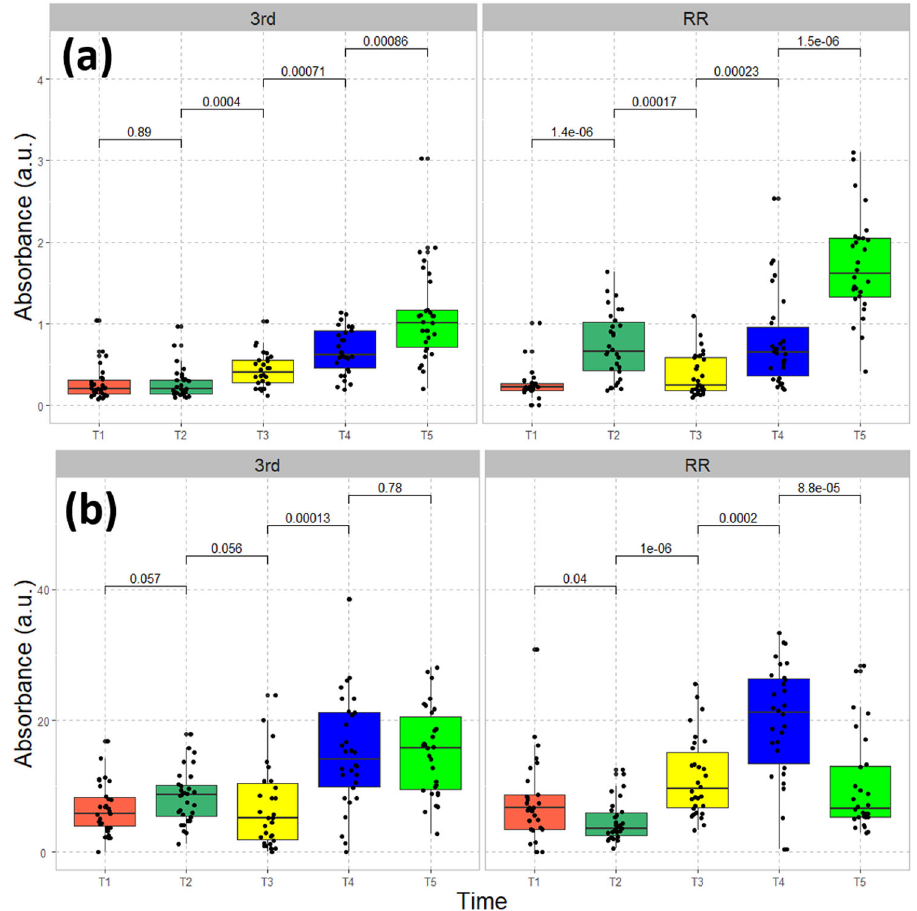
Fig. 3 Seasonal dynamics of P from leaf-tissue samples. a Inorganic and b organic P in leaf-tissue samples taken over the growing season from the two fi eld experiments at 3rd Street and Red River. P- values derived from pairwise comparisons are shown on the horizontal